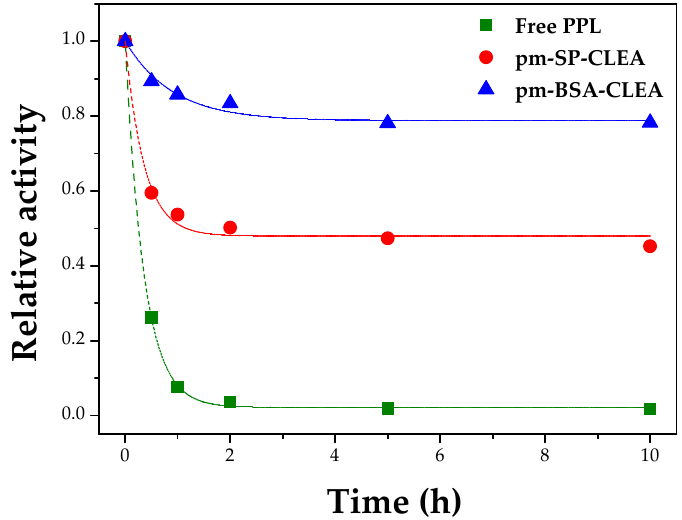
Figure 9. Thermal inactivation profiles of free and immobilized PPL at 40 ◦ C and pH 8.0 under 150 rpm stirring. Biocatalyst preparation conditions: treatment of PPL surface with dodecyl aldehyde (PPL/dodecyl aldehyde mass ratio of 1:1), aggregation/precipitation with ethanol (enzyme solution/ethanol volume ratio of 1:3) in presence of PPL/BSA/SMNPs or PPL/SP/SMNPs mass ratio of 1:1.5:1.5 and starch (0.8% w / v ) for 0.5 h, followed by treatments with glutaraldehyde (5 µ moles of glutaraldehyde/mg total protein), for 15 h at 4 ◦ C under 150 rpm stirring, and with α -amylase at 25 ◦ C for 2 h. Activity assay conditions: hydrolysis of 217.9 mM tributyrin solution at 40 ◦ C and pH 8.0 for 5 min under 500 rpm stirring.